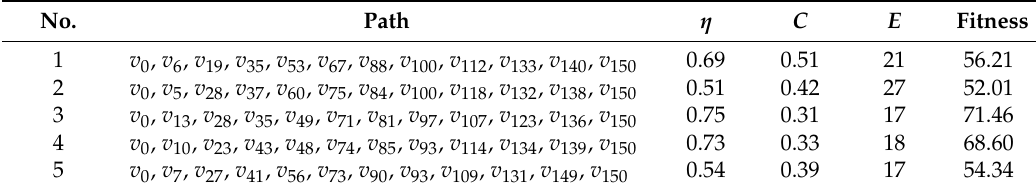
Table 6. Results after 50 iterations.